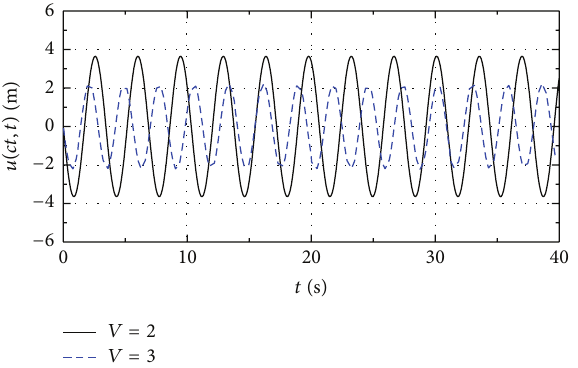
Figure 8: The displacement of the string at 𝑥 = 𝑐𝑡 when the mass moves at supersonic velocities.